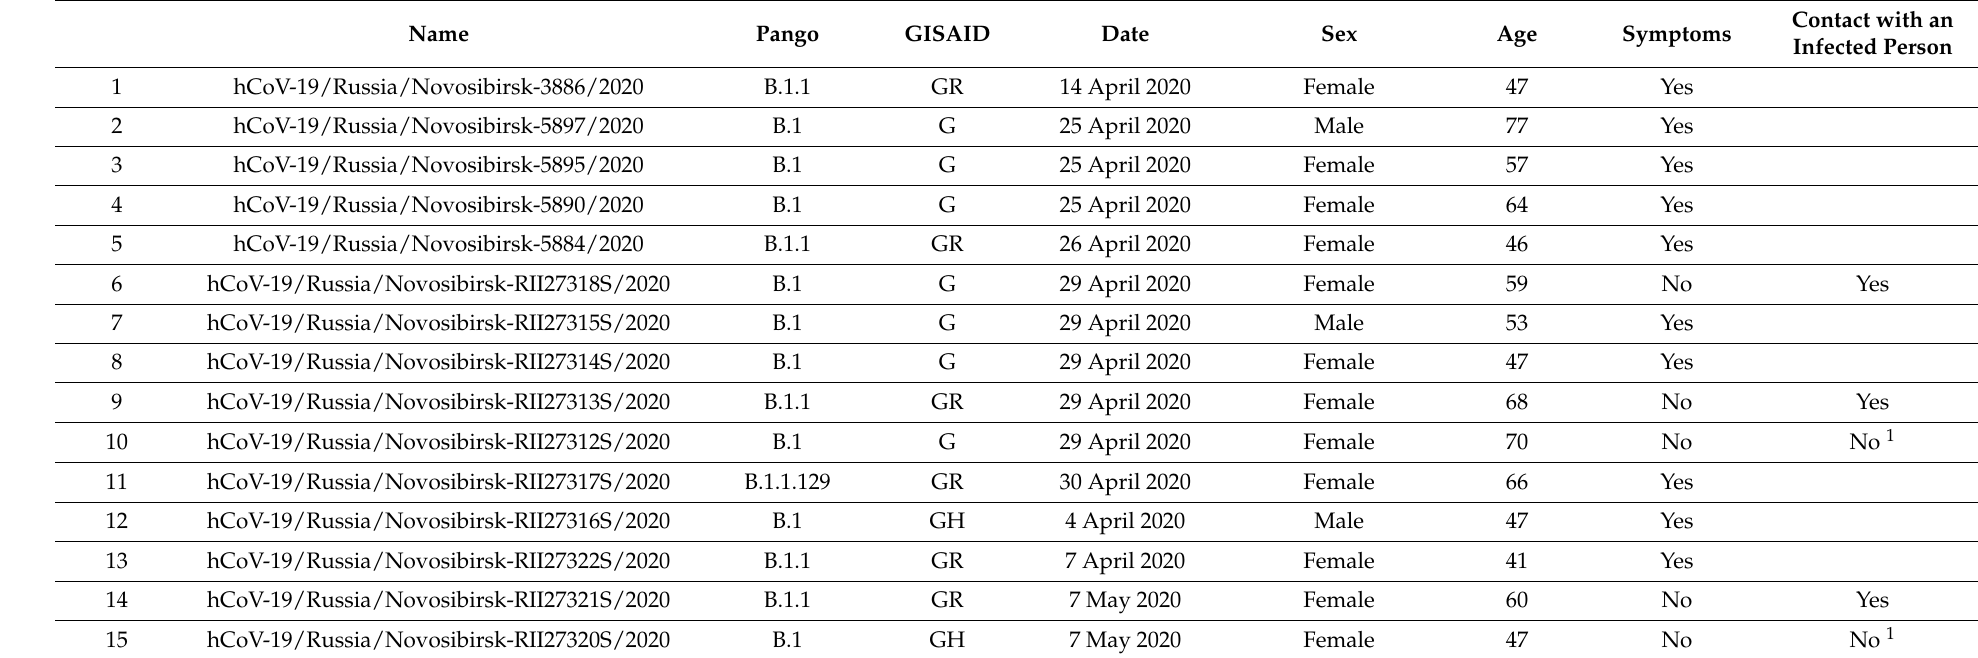
Table 2. The genetic and epidemiological features of sequenced